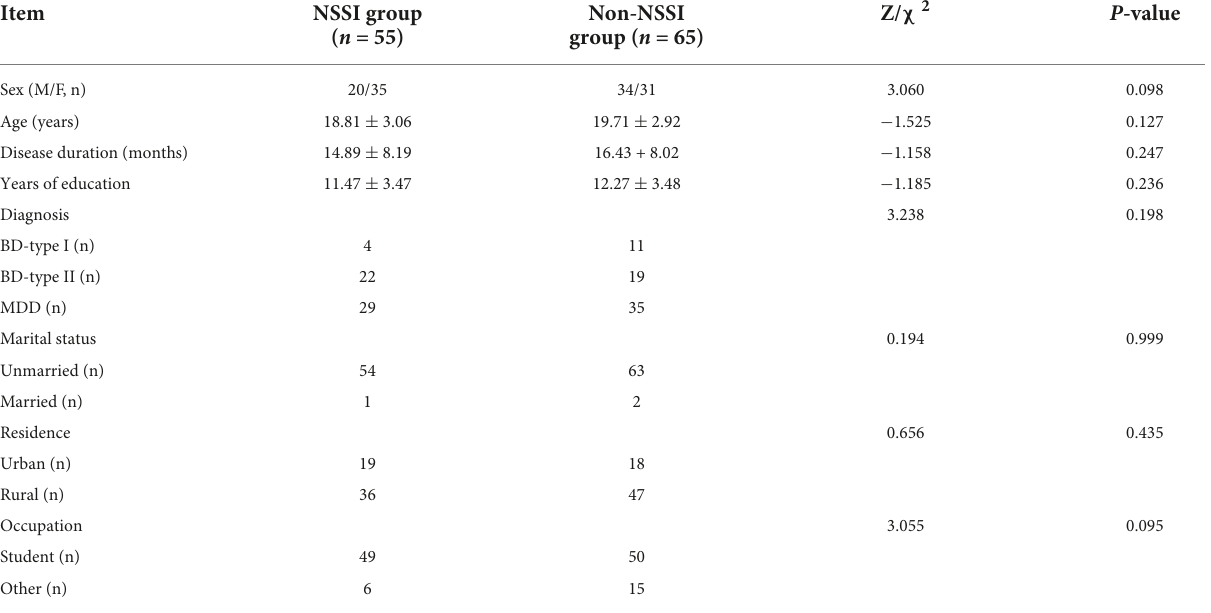
TABLE 1 Demographic information.